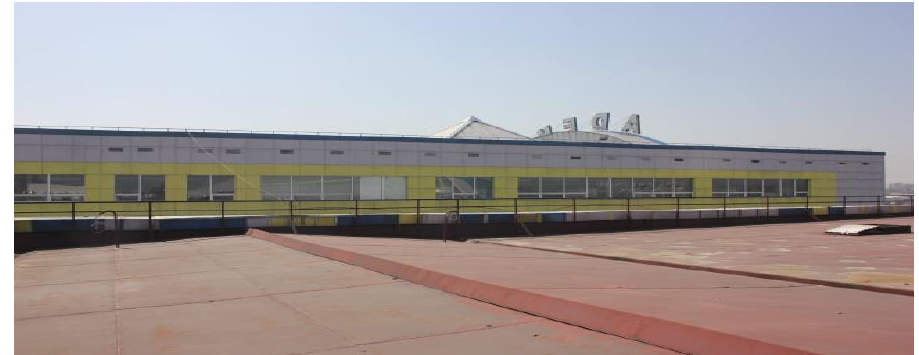
Figure A5. Steel with Wall Panels.